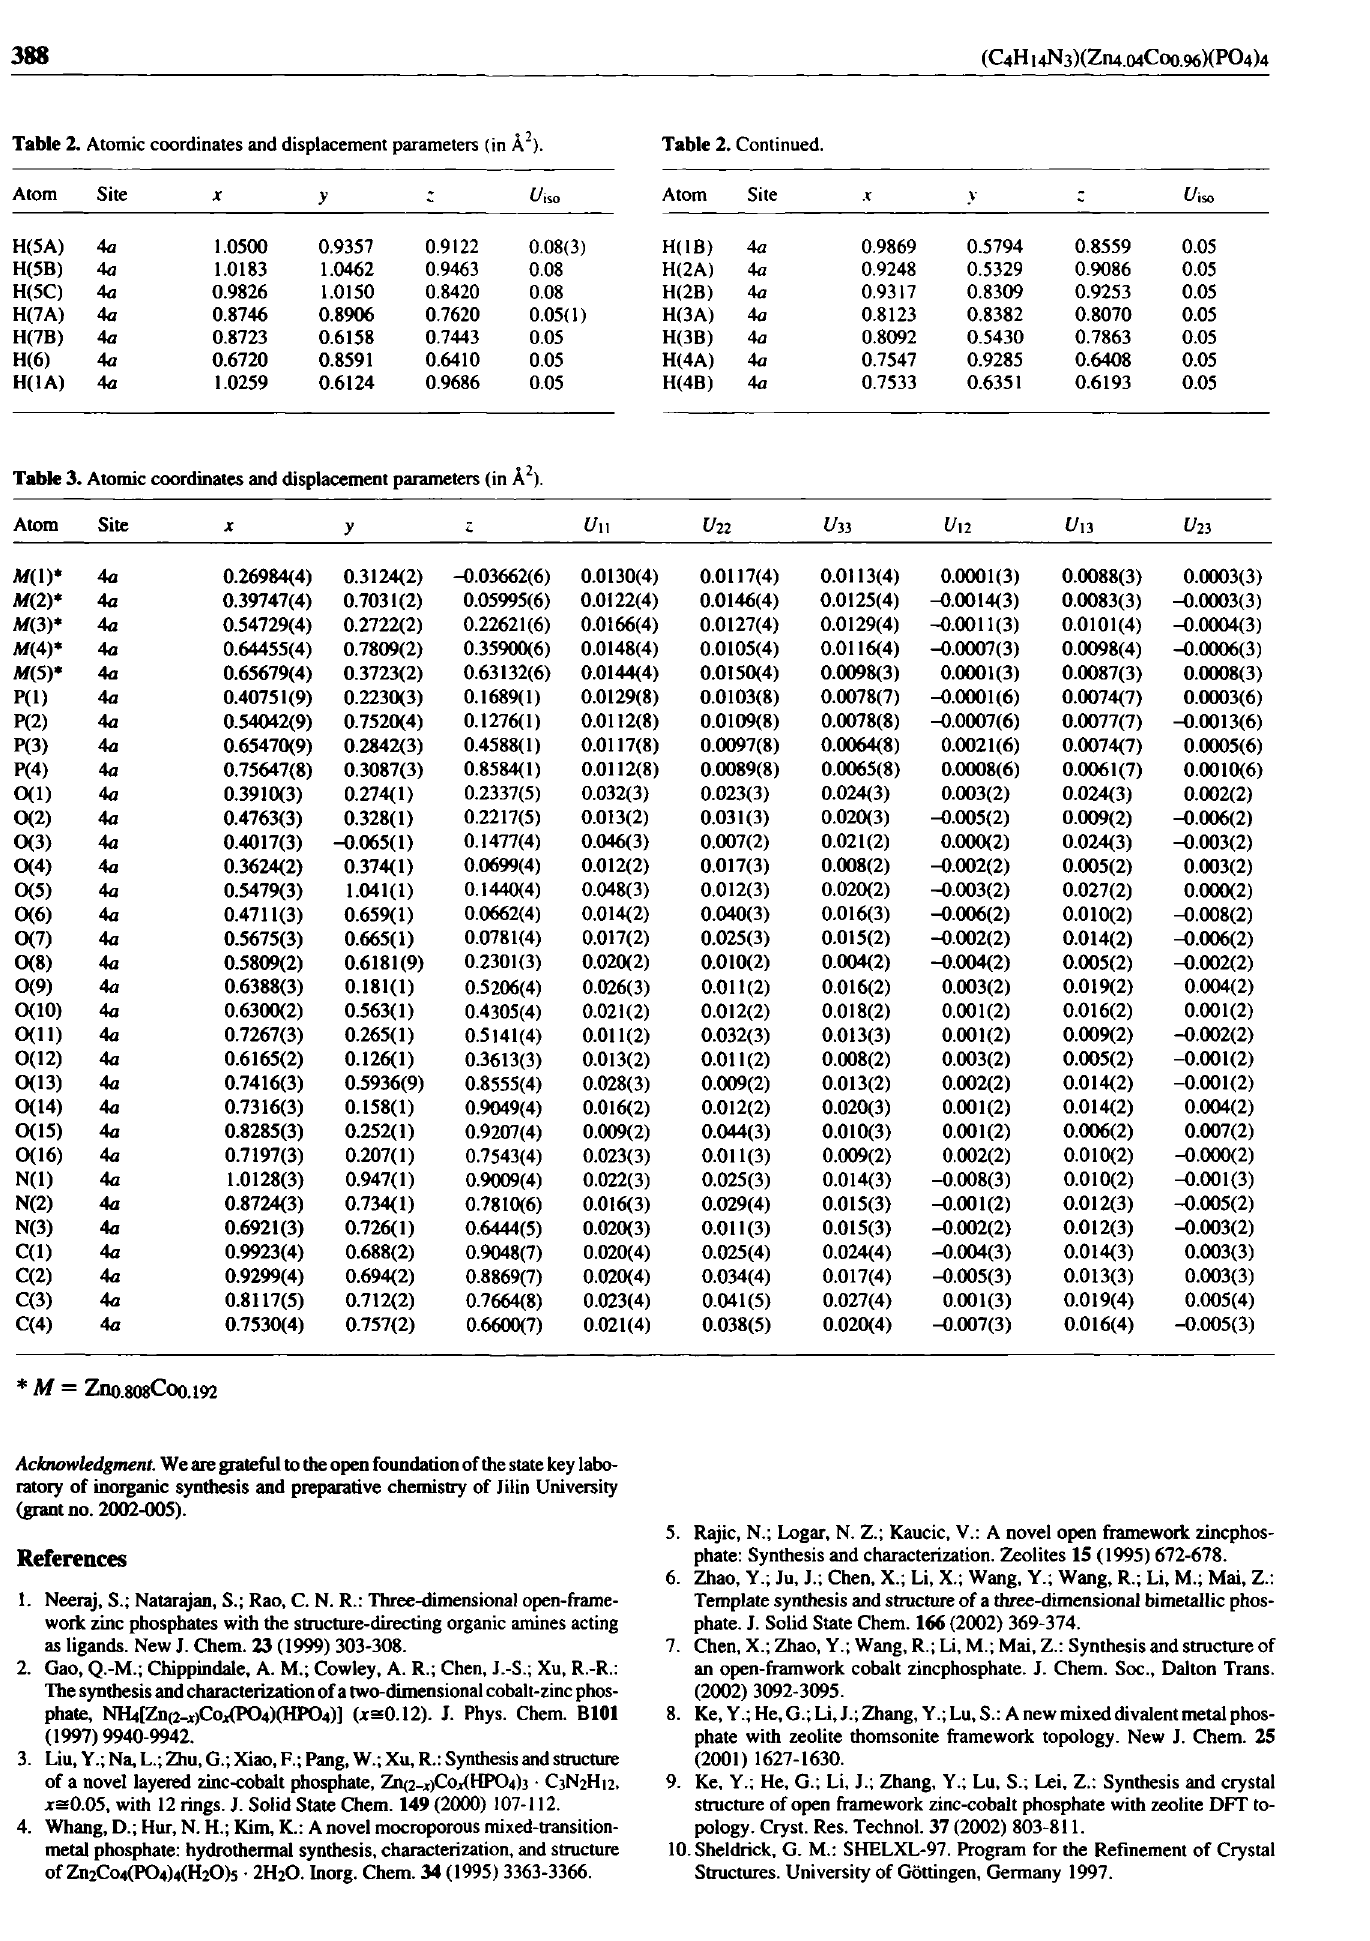
Table 2. Atomic coordinates and displacement parameters (in À 2 ).